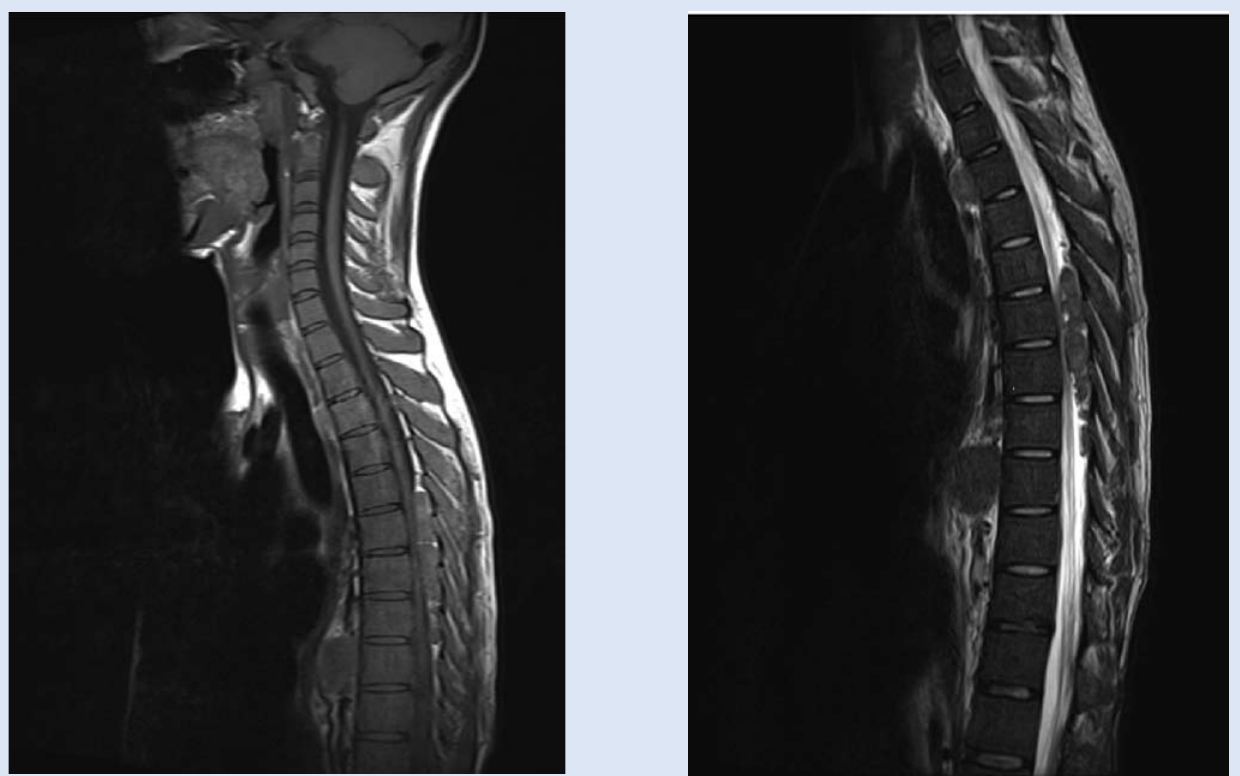
Fig. 2. Sagittal T1- and T2-weighted sequences demonstrate extradural lobulated soft-tissue masses which cause compression of the spinal cord at levels T5 - T8. These masses are iso-intense to the marrow within the adjacent vertebral bodies. There is enlargement of the central canal distal to the region of compression. There is also a mass anterior to the T9 vertebral